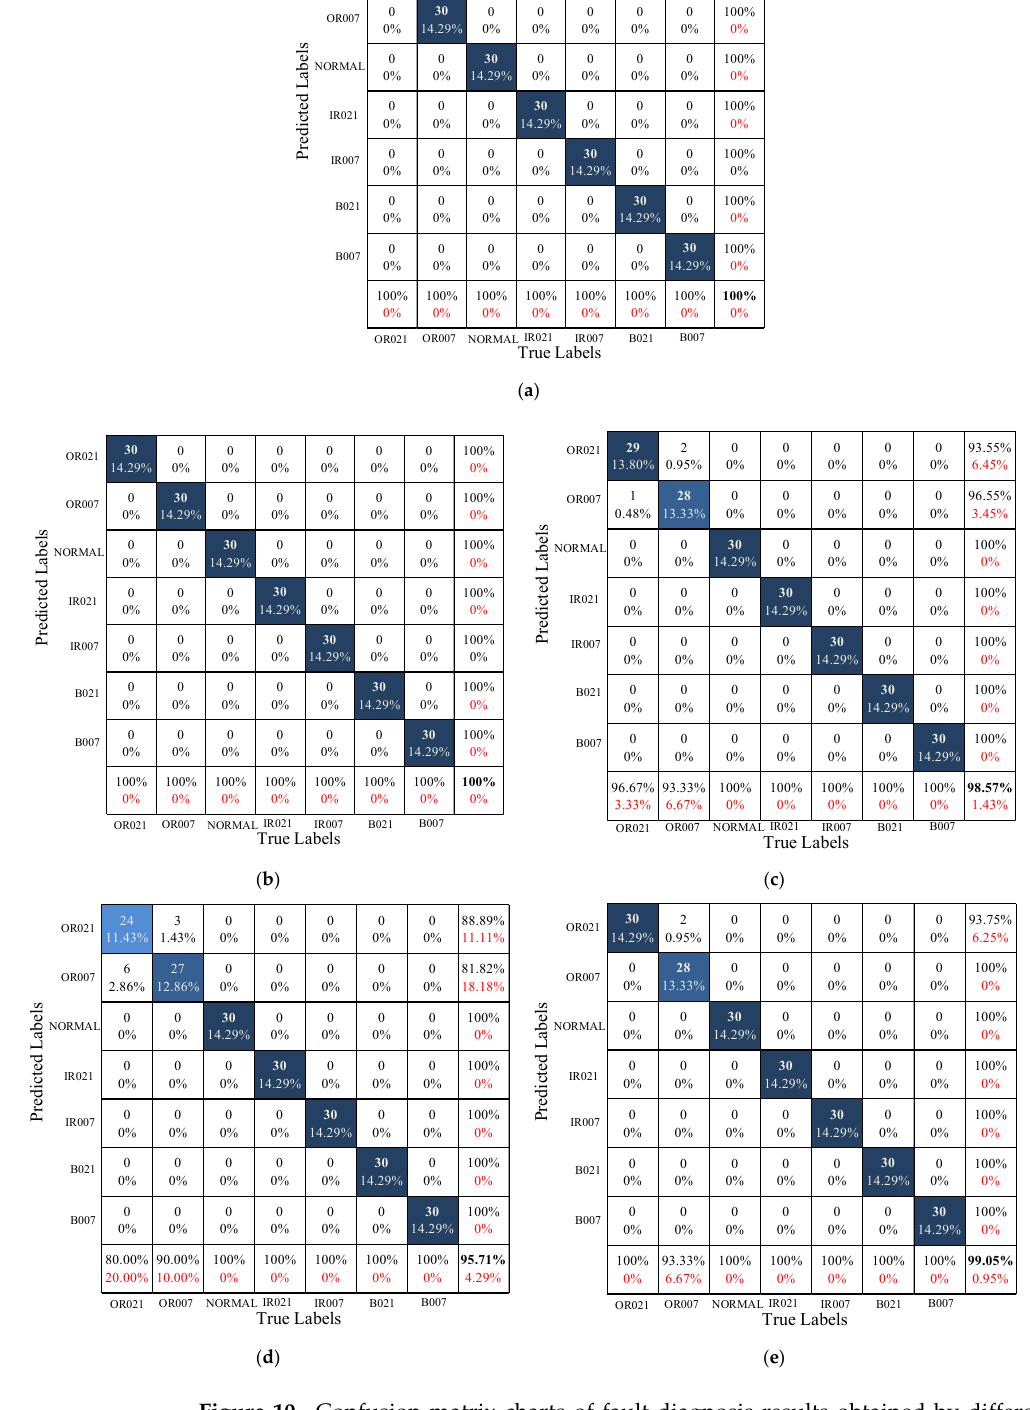
Table 7. Average results for each model.